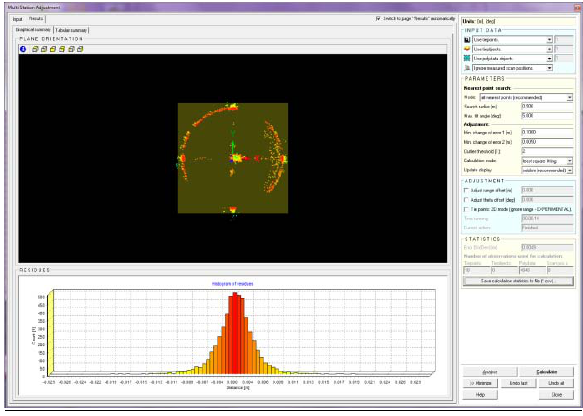
Figure3. Standard deviation of the different scan positions The three dimensional models obtained with the inner and outer scanning are shown in figure 4.